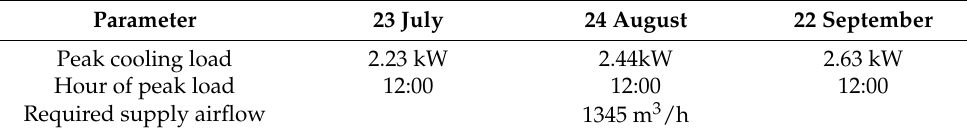
Table 6. Determination of the supply airflow.